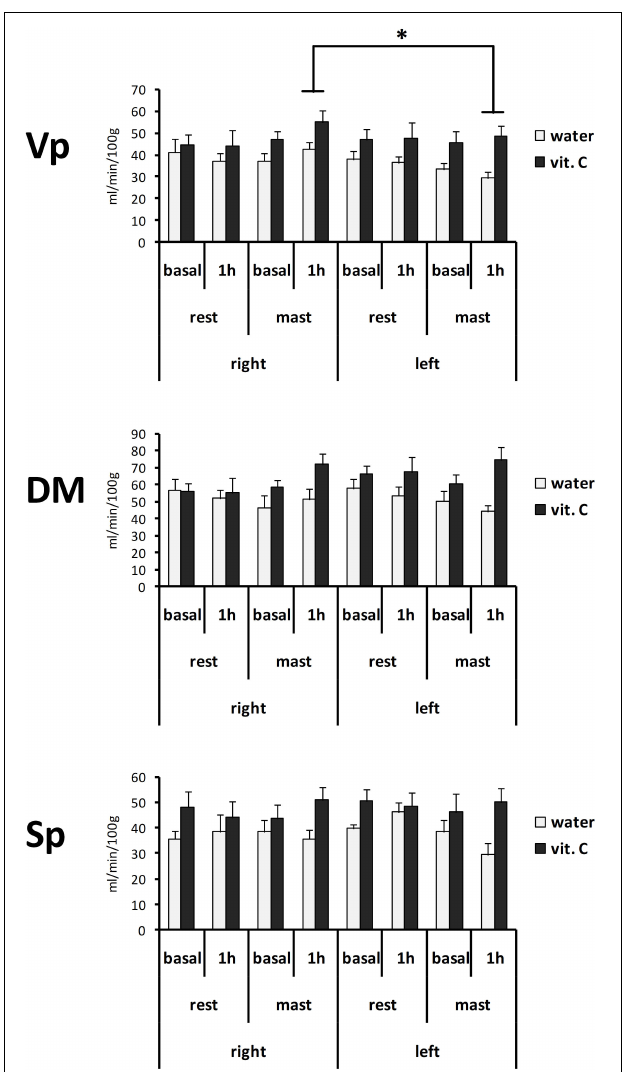
FIGURE 4 | Normalized perfusion values from the right or left side of the Vp, DM, and Sp nuclei at first (basal) or second (1 h) ASL-MRI scan, after a vit. C supplemented (vit. C) or control (water) lunch; the second scan was acquired after resting (rest) or masticating (mast) for 1 h. Bars represent the mean ratio between the perfusion values and the global perfusion values obtained from the same scan. There was no significant effect for the water/vit. C factor. *Tukey post hoc test, p <